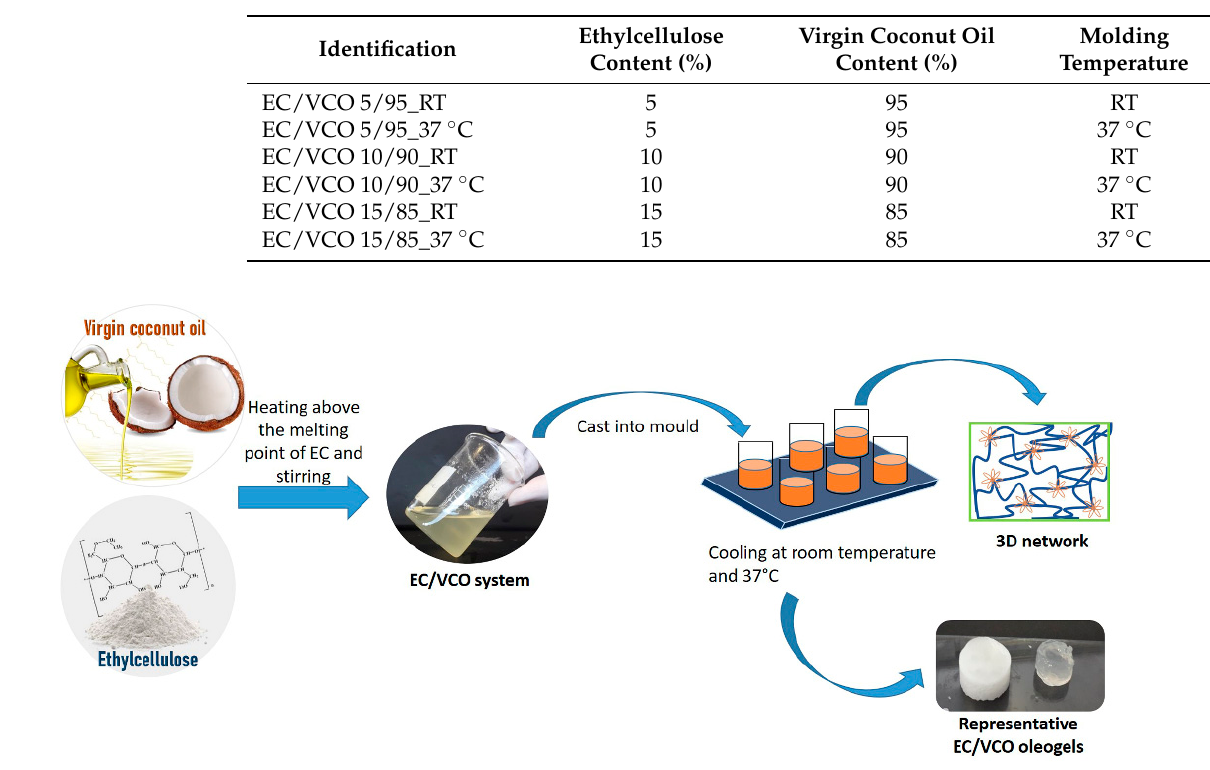
Table 1. Experimental conditions of the EC/VCO-based oleogels. Identification